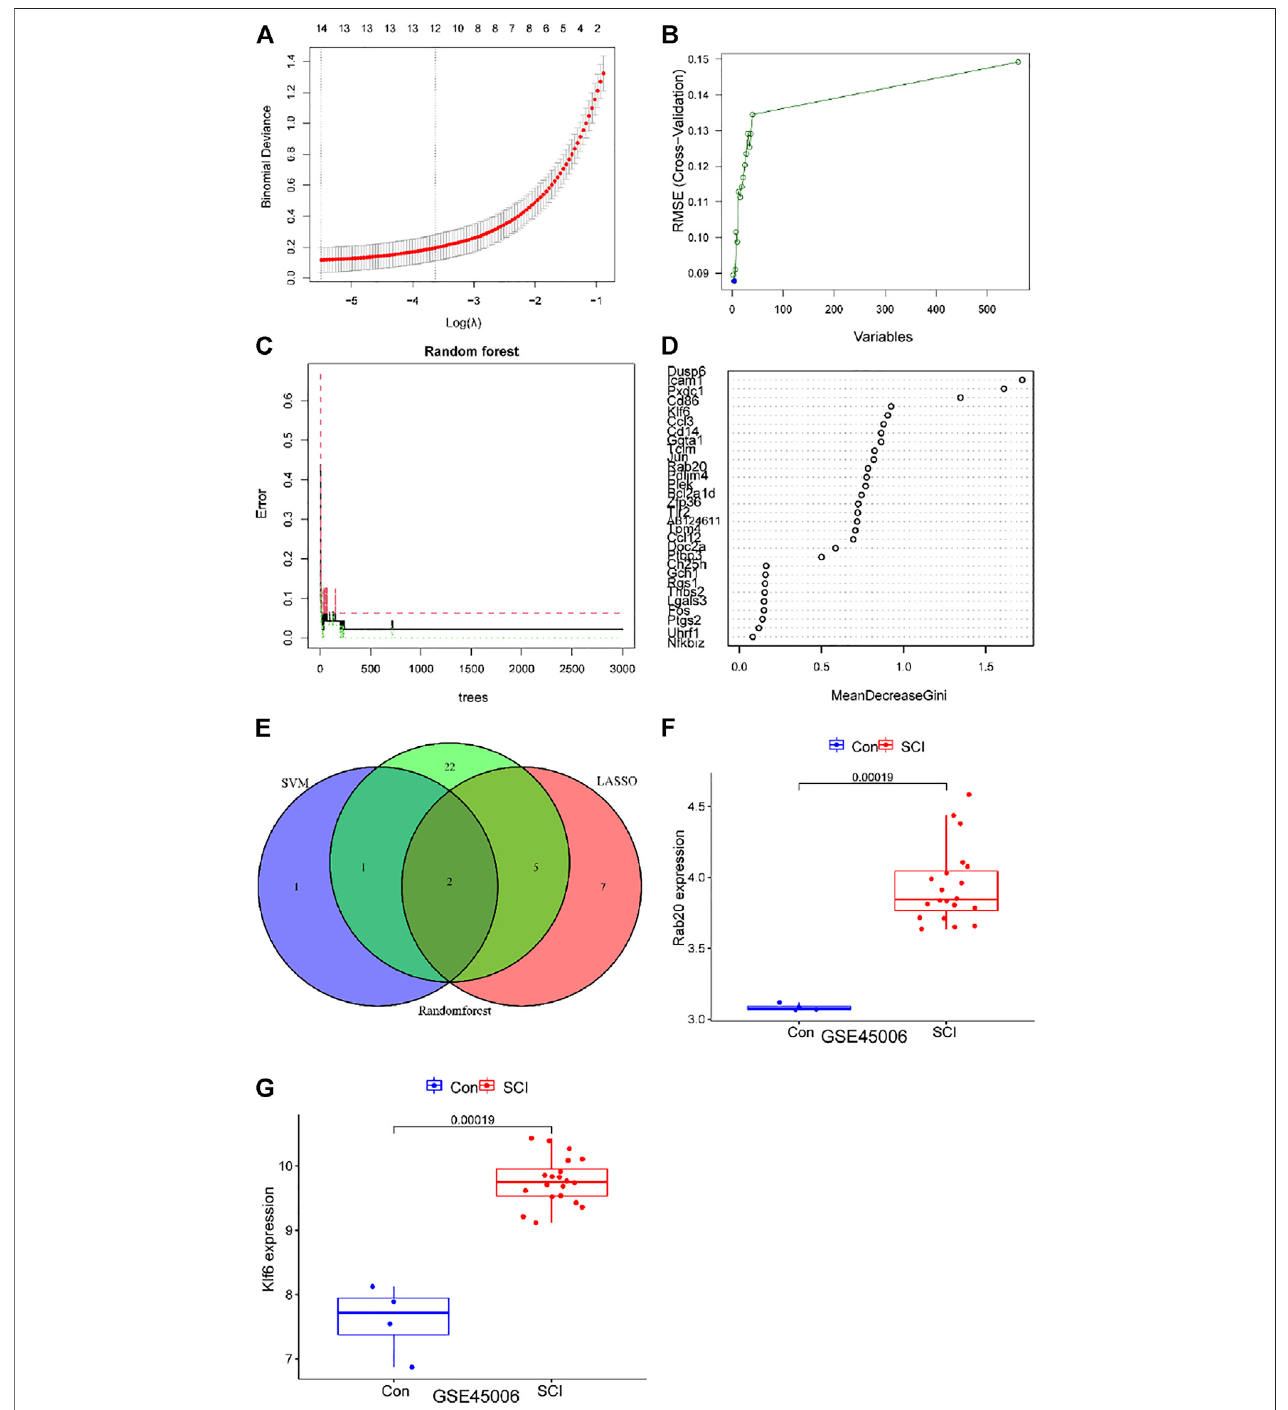
FIGURE 4 | Screening of key genes via the comprehensive strategy. (A) screening key markers using Least absolute shrinkage and selection operator (LASSO) logistic regression method. (B) screening key markers through support vector machine recursive feature elimination (SVMRFE) method. (C,D) random forest (RF) strategytoscreenbiomarkers. (E) Venndiagramdisplayedtheintersectionofkeymarkersobtainedbythethreemethods. (F,G) TheexpressionlevelsofRab20andKlf6 in GSE45006.